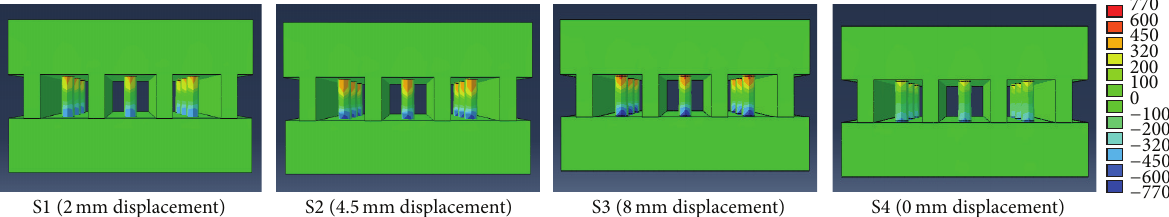
Figure 14: Axial stress component (S22) contours distributed over the STE-0.10 model according to individual loading steps (Unit: Mpa).